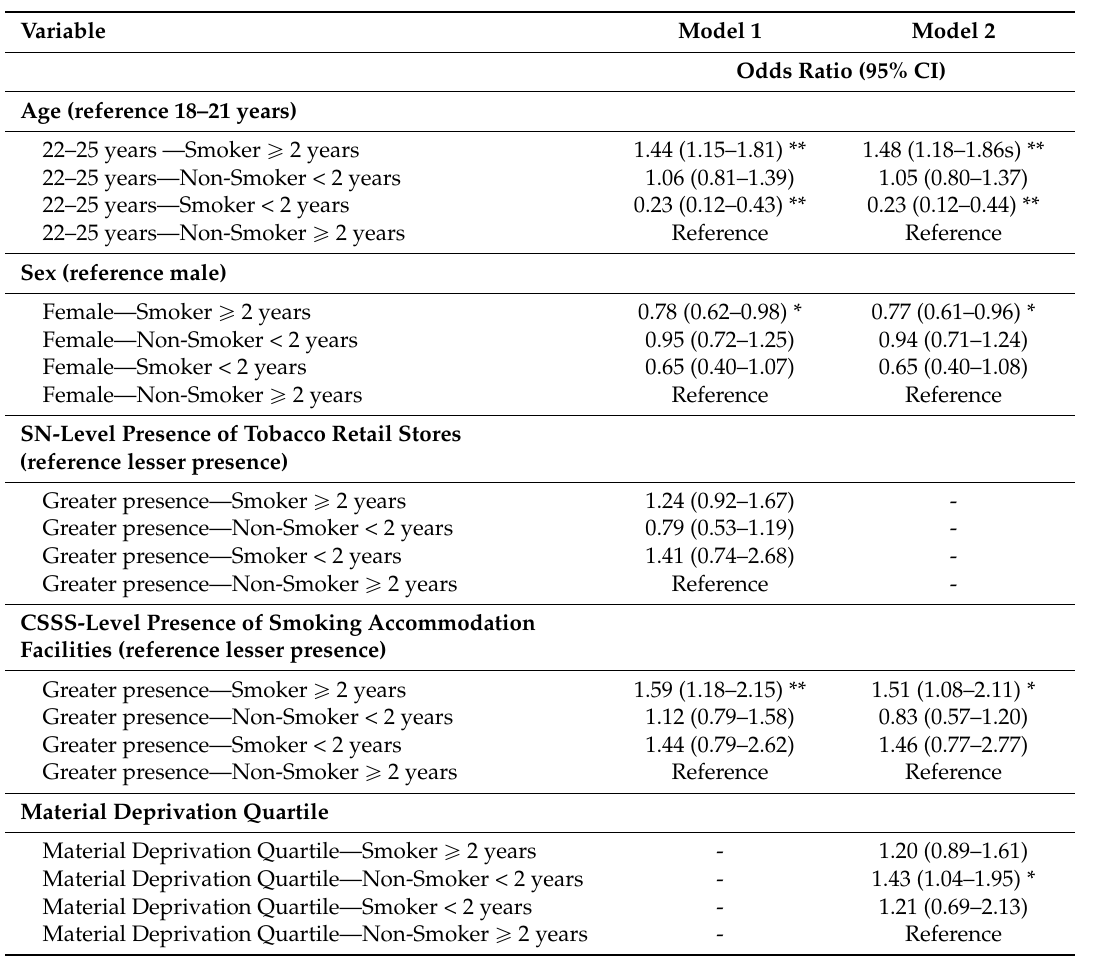
Table 5. Results of fully-adjusted multinomial multilevel regression models predicting smoking trajectory over 2 years among 2070 adults living in Montreal Canada in